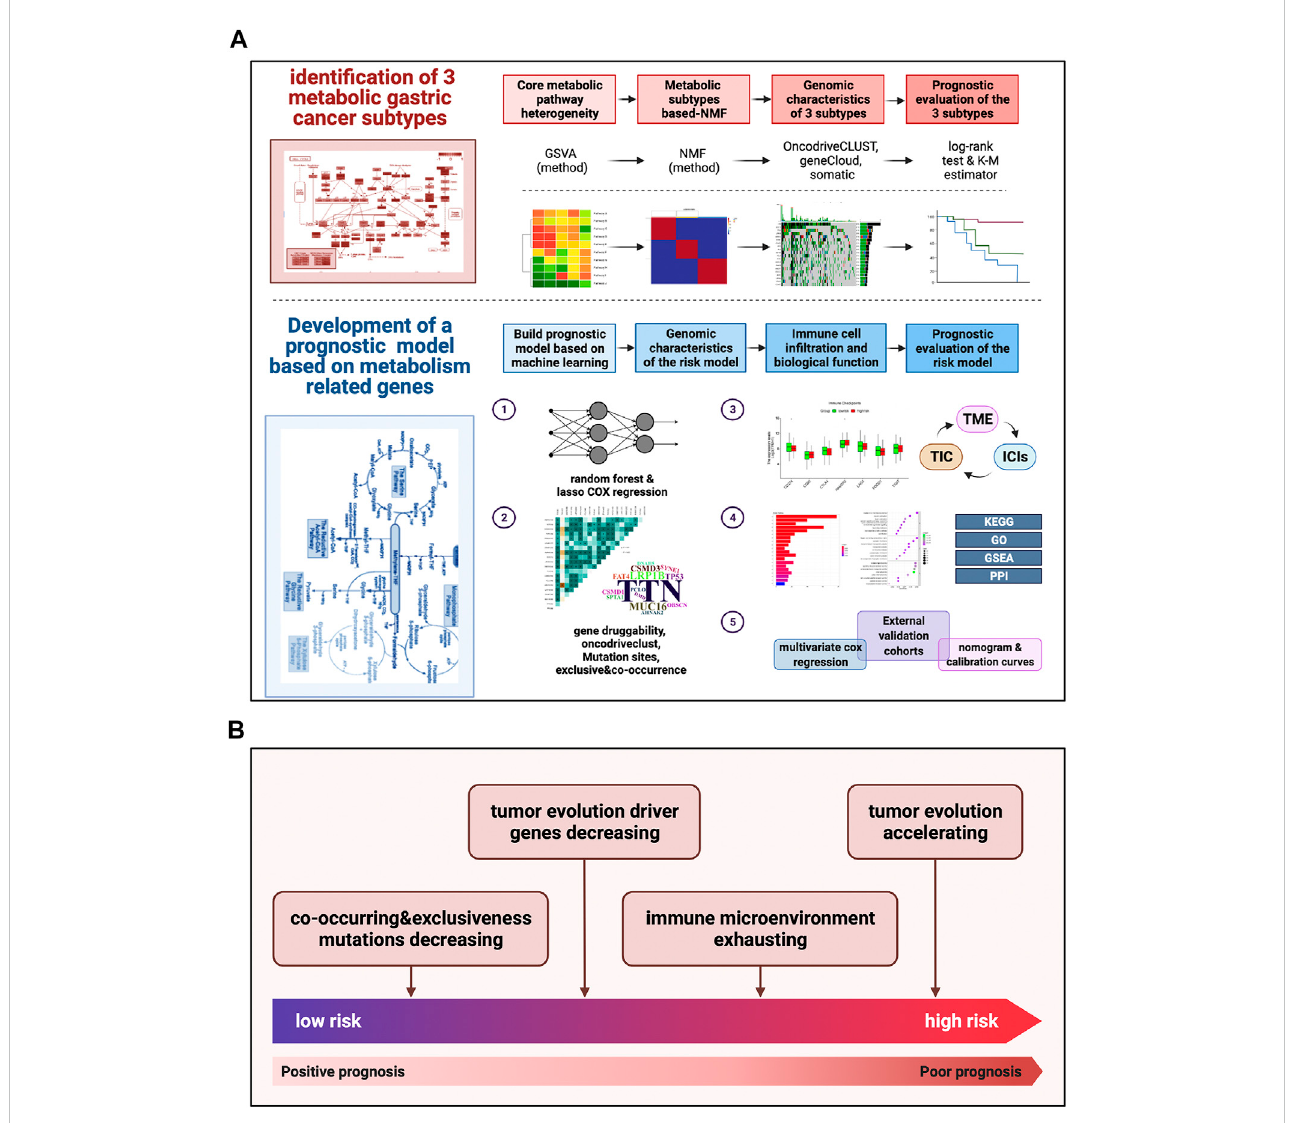
FIGURE 1 Pipeline of the study design and a summary of main work and fi ndings (A) Our detailed pipeline of the study design. (B) A summary of our main work and fi ndings.